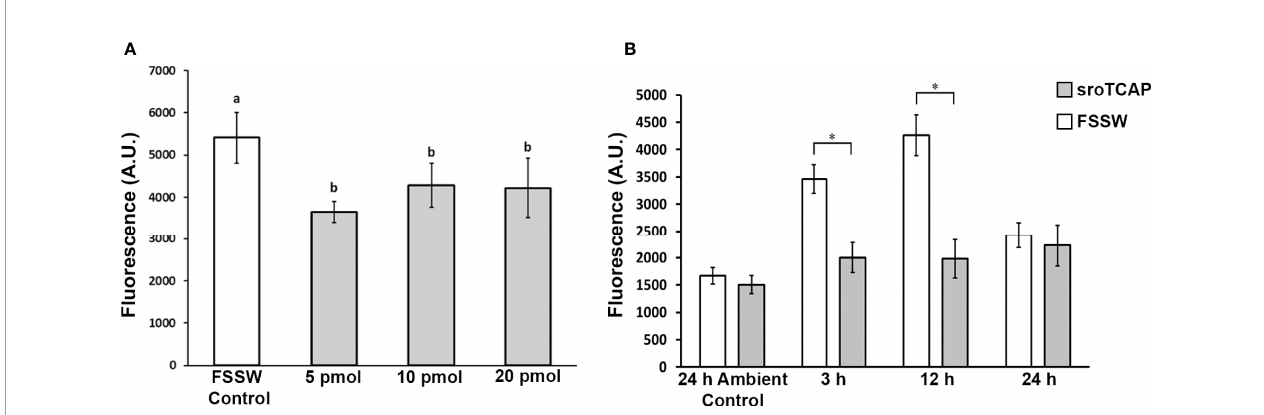
FIGURE 5 | PhagocytosisactivityofSROhemocytesexposedtoambientandstress conditionsinjectedwithsroTCAP or FSSW. (A) Hemocytephagocytosis activityfollowing3 hsroTCAPtreatments(5,10and20 pmol),comparedtoFSSWcontrol(0pmol).Oystersusedwere inambientconditionsof34pptand22°C(non-stressed). Lowercaseletters indicatesigni fi cantdifferences betweentreatments (ANOVA,p< 0.05). (B) Hemocytephagocytosisactivityatdifferenttimepoints(3,12and24h) post-stress(30°C, 15ppt) followingIM administrationof5 pmolsroTCAPorFSSW(control)treatment. Ambientcontrol(non-stressed34 pptand22°C)showshemocytephagocytosisactivity24hpost5